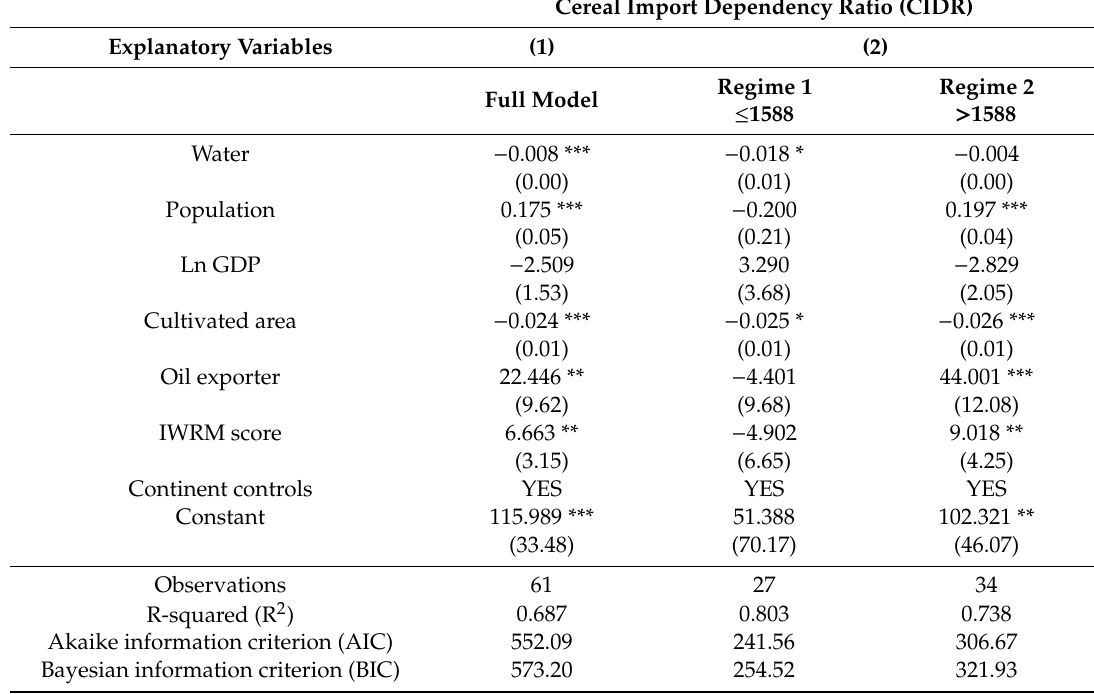
Table 5. Ordinary least squares (OLS) and threshold estimations for the additional determinant of IWRM for the year